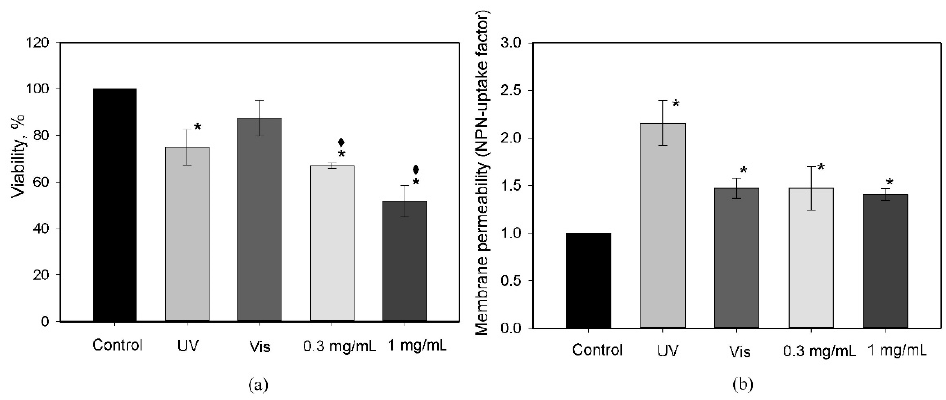
Figure 1. Effects of light and TiO 2 on S. Typhimurium cell: ( a ) viability; ( b ) outer membrane permeability. The experiments were performed at 37 ◦ C in PBS buffer (pH 7.4), containing 0.1% of glucose. The initial S. Typhimurium cell concentration was 3 × 10 7 cfu/mL. Concentrations of TiO 2 are indicated in the figure. The cells were incubated for 60 min, the intensities of UV and Vis light were 30 and 40 mW/cm 2 respectively. * and ♦ mark experimental values which are significantly different from the control sample and other samples respectively (more details on statistical analysis are provided in Section 4.5).